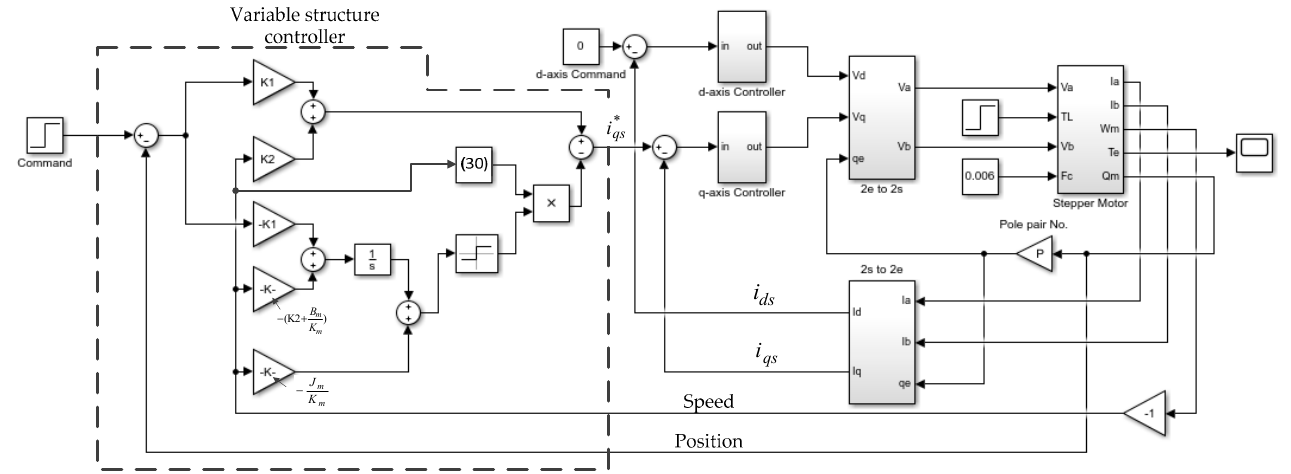
Figure 3. The schematic block diagram of VSC-based stepper motor drive system.